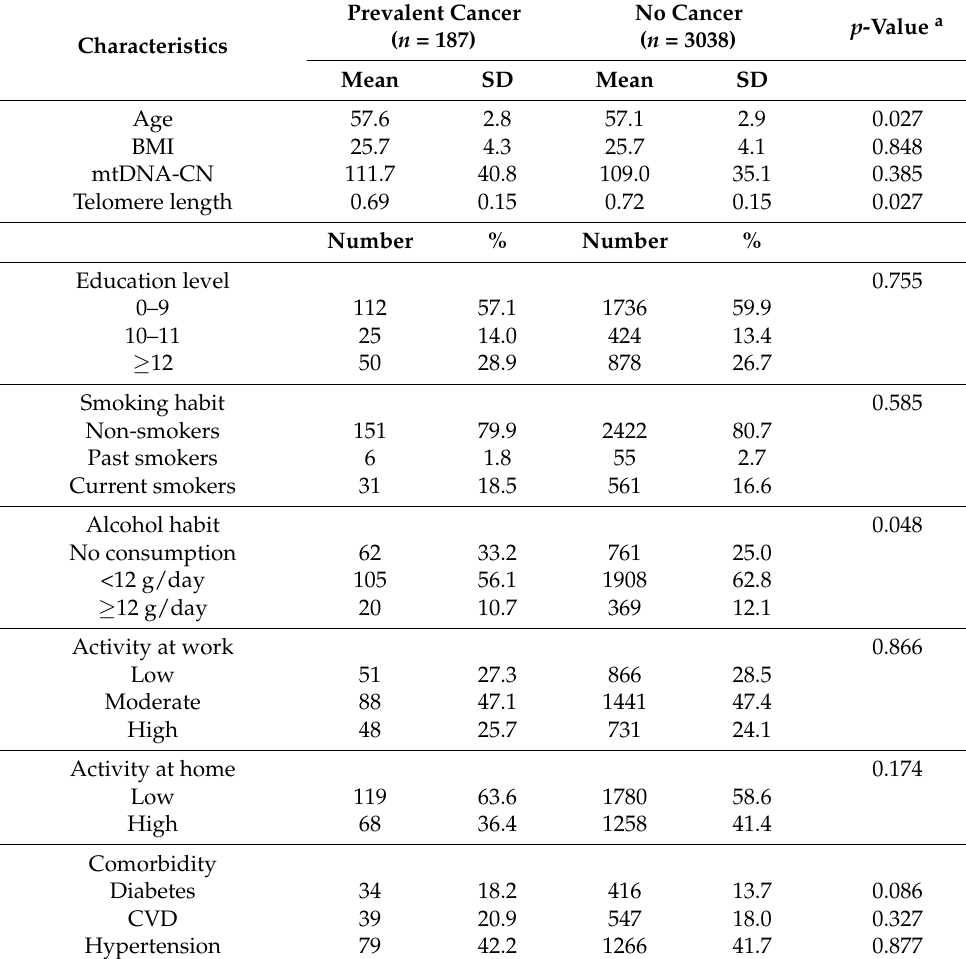
Table 1. Baseline characteristics of mtDNA-CN and telomere length stratified by prevalent and no cancer.